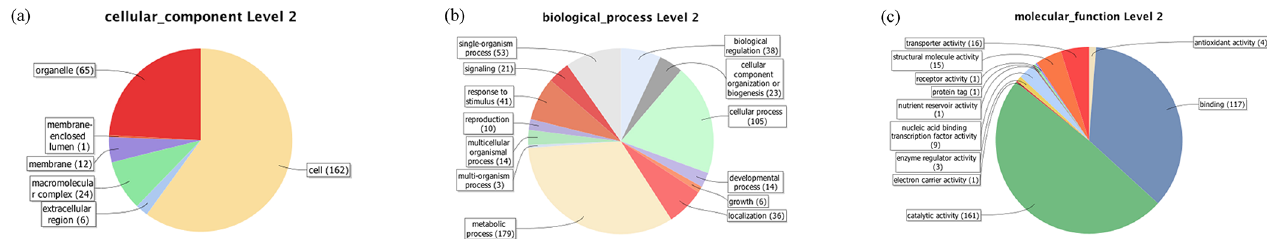
Fig 1. Gene ontology functional classification of key candidate genes. The functionalassignmentswith biologicalprocesses, molecular functions, and cellularcomponents are shown based on the number of proteinsand the convertedcorresponding